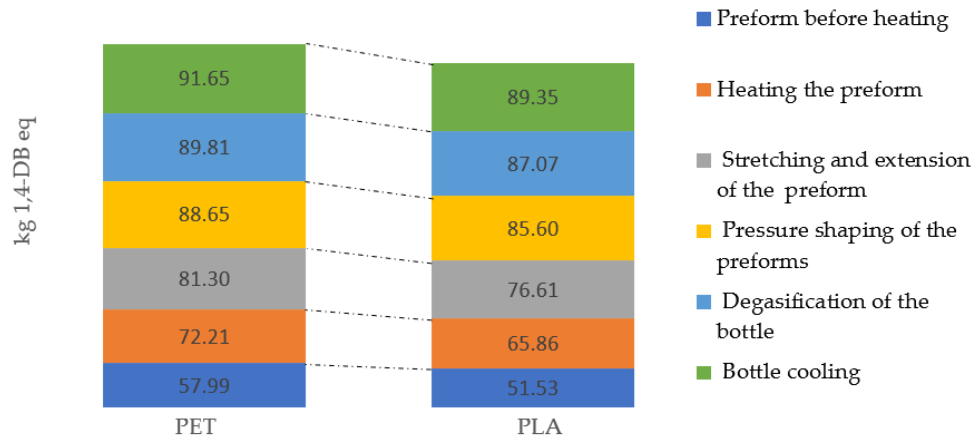
Figure 10. Freshwater aquatic ecotoxicity emissions throughout the entire bottle shaping process. Marine ecotoxicity has potentially the highest negative impact on the aquatic environ- ment. The highest similar emission levels were recorded for the degasification of the bottle, which was 91.65 kg 1,4-DB eq in PET bottle and 89.35 kg 1,4-DB eq PLA bottle operations (Figure 11).